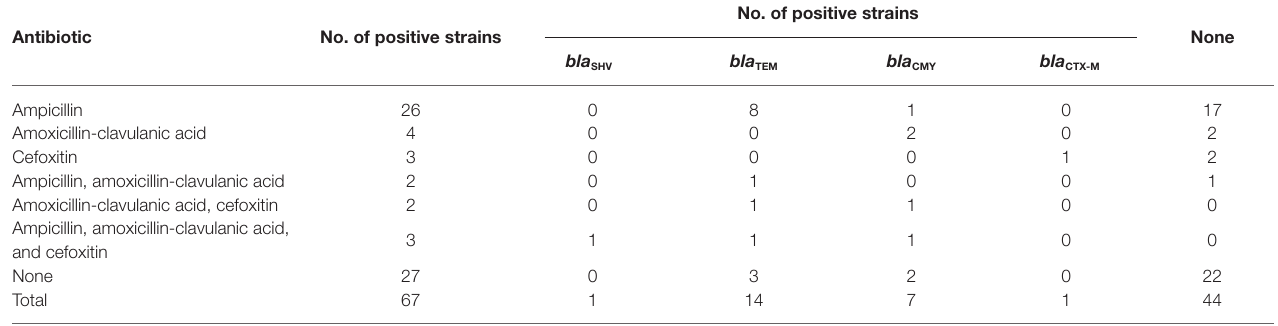
TABLE 3 | β -lactamase genotypes identified in β -lactam-resistant E. coli .